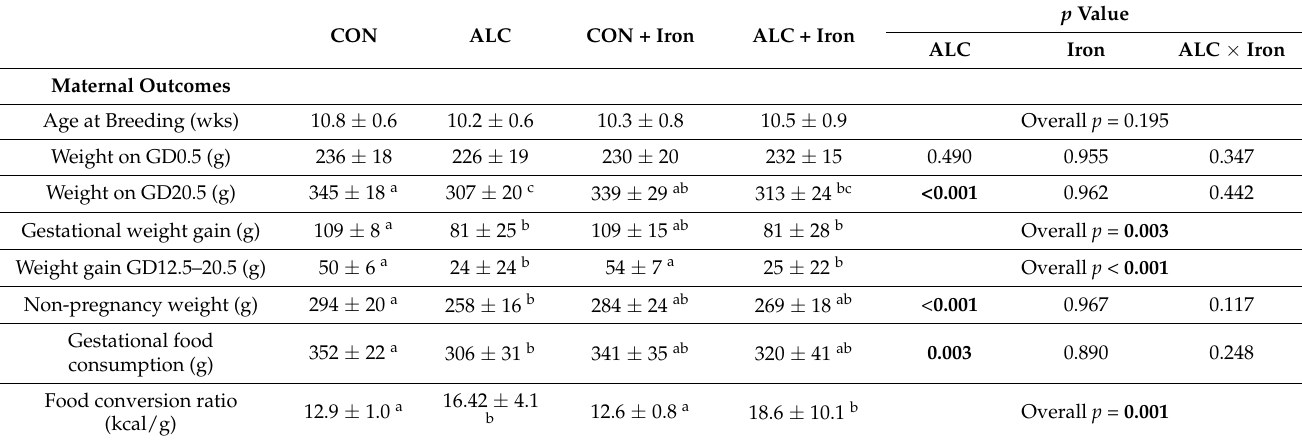
Table 1. Alcohol exposure, but not iron supplementation, altered maternal and litter